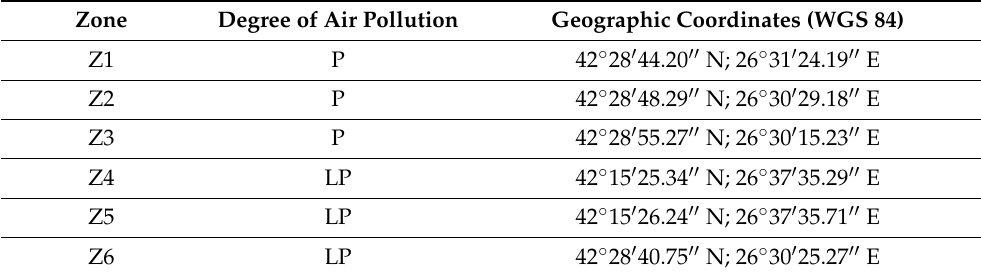
Table 1. Areas for collecting mulberry